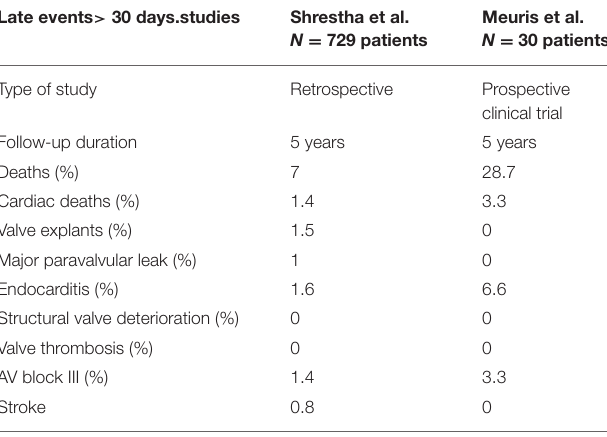
TABLE 5 | Long-term outcomes of the Perceval bioprosthesis.